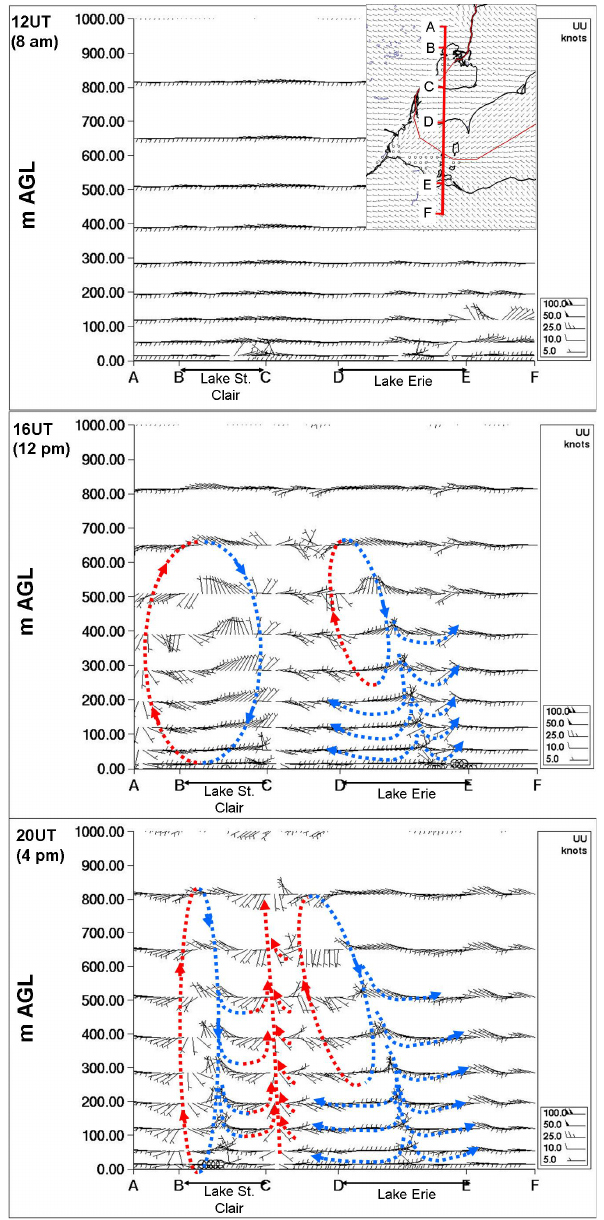
Fig. 20. Cross-section of 3-D wind fields across Lakes St. Clair and Erie at (a) 12:00 UT (08:00 a.m.), (b) 16:00 UT (12:00 noon), and (c) 20:00 UT (04:00 p.m.). Net upward motion streamlines are sketched in red, downward motion in blue. Inset: location of the cross-section, superimposed on 20:00 UT surface winds.